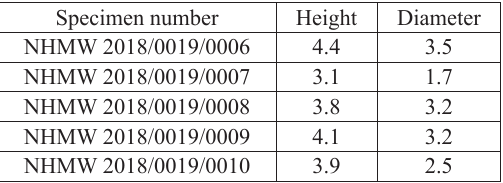
in lower third; suture deeply incised. Last whorl globular, regularly convex with maximum diameter in mid-height; base moderately convex, rapidly contracting. Aperture dis- tinctly angulated at posterior tip, contact with last whorl below its periphery. Umbilicus narrow, partly covered by thin and narrow inner lip. Operculum solid, posteriorly an- gulated. Outer surface with central nucleus, prominent con- centric growth lines, distinctly concave. Inner surface con- vex with shallow, irregular dents; height/width ratio c. 1.4. Table 2. Measurements (in mm) of Bithynia erzurumensis sp.